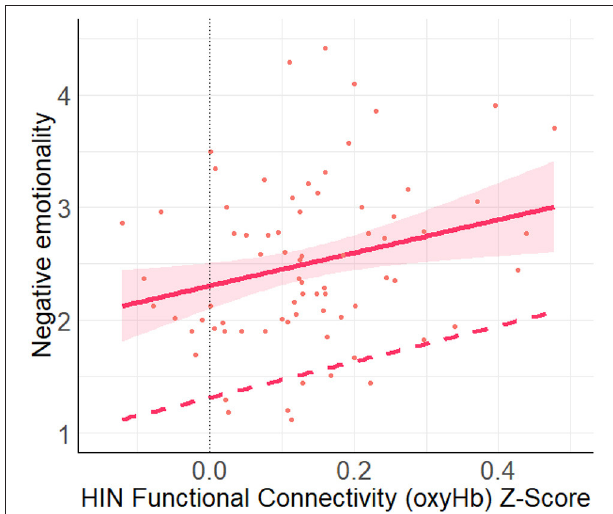
FIGURE 5 | This figure shows the unadjusted (solid line) and adjusted relation (covariates: FPN, DMN, Control, income, age) between HIN functional connectivity (oxyHb) Z-score and negative emotionality. Here, we found a significant positive relation between the HIN and negative emotionality ( p = 0.038). Shaded regions represent 90% confidence interval for the raw (unadjusted)